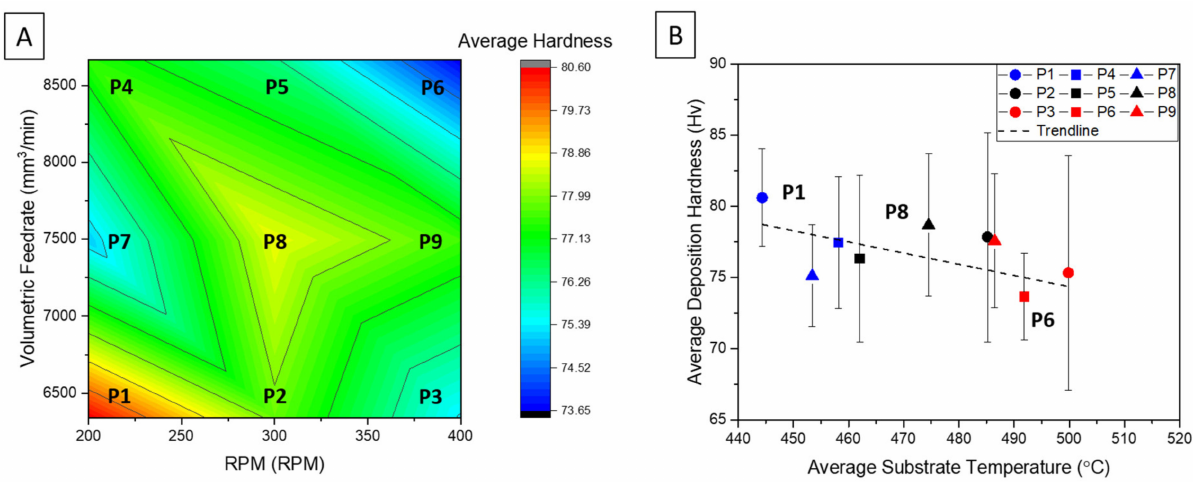
Figure 2. ( A ). Color contour plot contrasting the material volumetric feed rate to the RPM of the tool. ( B ) Deposition cross-sectional hardness versus average temperature. Key: circles correlate to 200 RPM, squares to 300 RPM, and triangles to 400 RPM. Blue data points correlate to deposition ratio of 0.55, black data points correlate to a deposition ratio of 0.65, and red data points correlate to a deposition ratio of